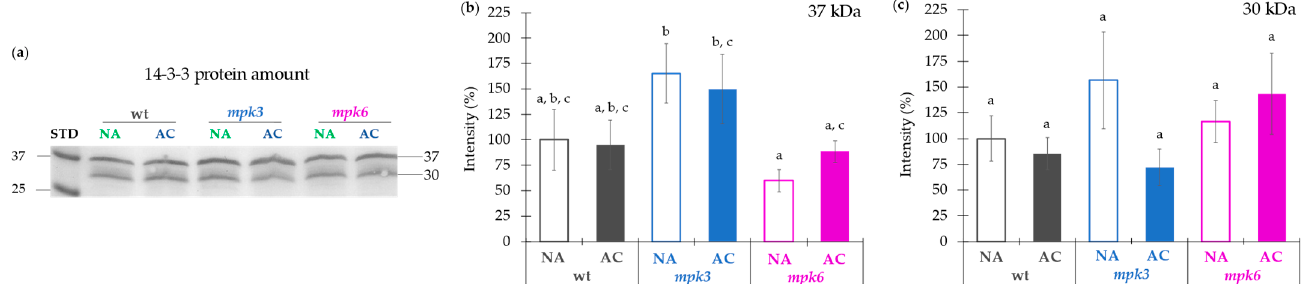
Figure 4. Effect of cold acclimation on the amounts of 14-3-3 proteins from wild type, mpk3, and mpk6 plants. ( a ) Immunodetection of 14-3-3 proteins in PMV isolated from NA or AC wild type, mpk3, and mpk6 plants. ( b ) 37 kDa protein levels and ( c ) 30 kDa protein levels. ( b , c ) Densitometric estimation of the intensity of the bands in ( a ); comparison was done between the band intensity from the NA or AC condition with respect to the NA wild type band intensity. Loading control gels are presented in Figure S3a. Normalization of the protein bands in the Western blots was performed considering the intensity of the corresponding lane in the Coomassie stained gel and the blot background when different blots were compared. Values presented in panels ( b , c ) are means of six replicates from five independent biological samples ± SE. α ≤ 0.05 (ANOVA test). Different letters indicate significant differences.